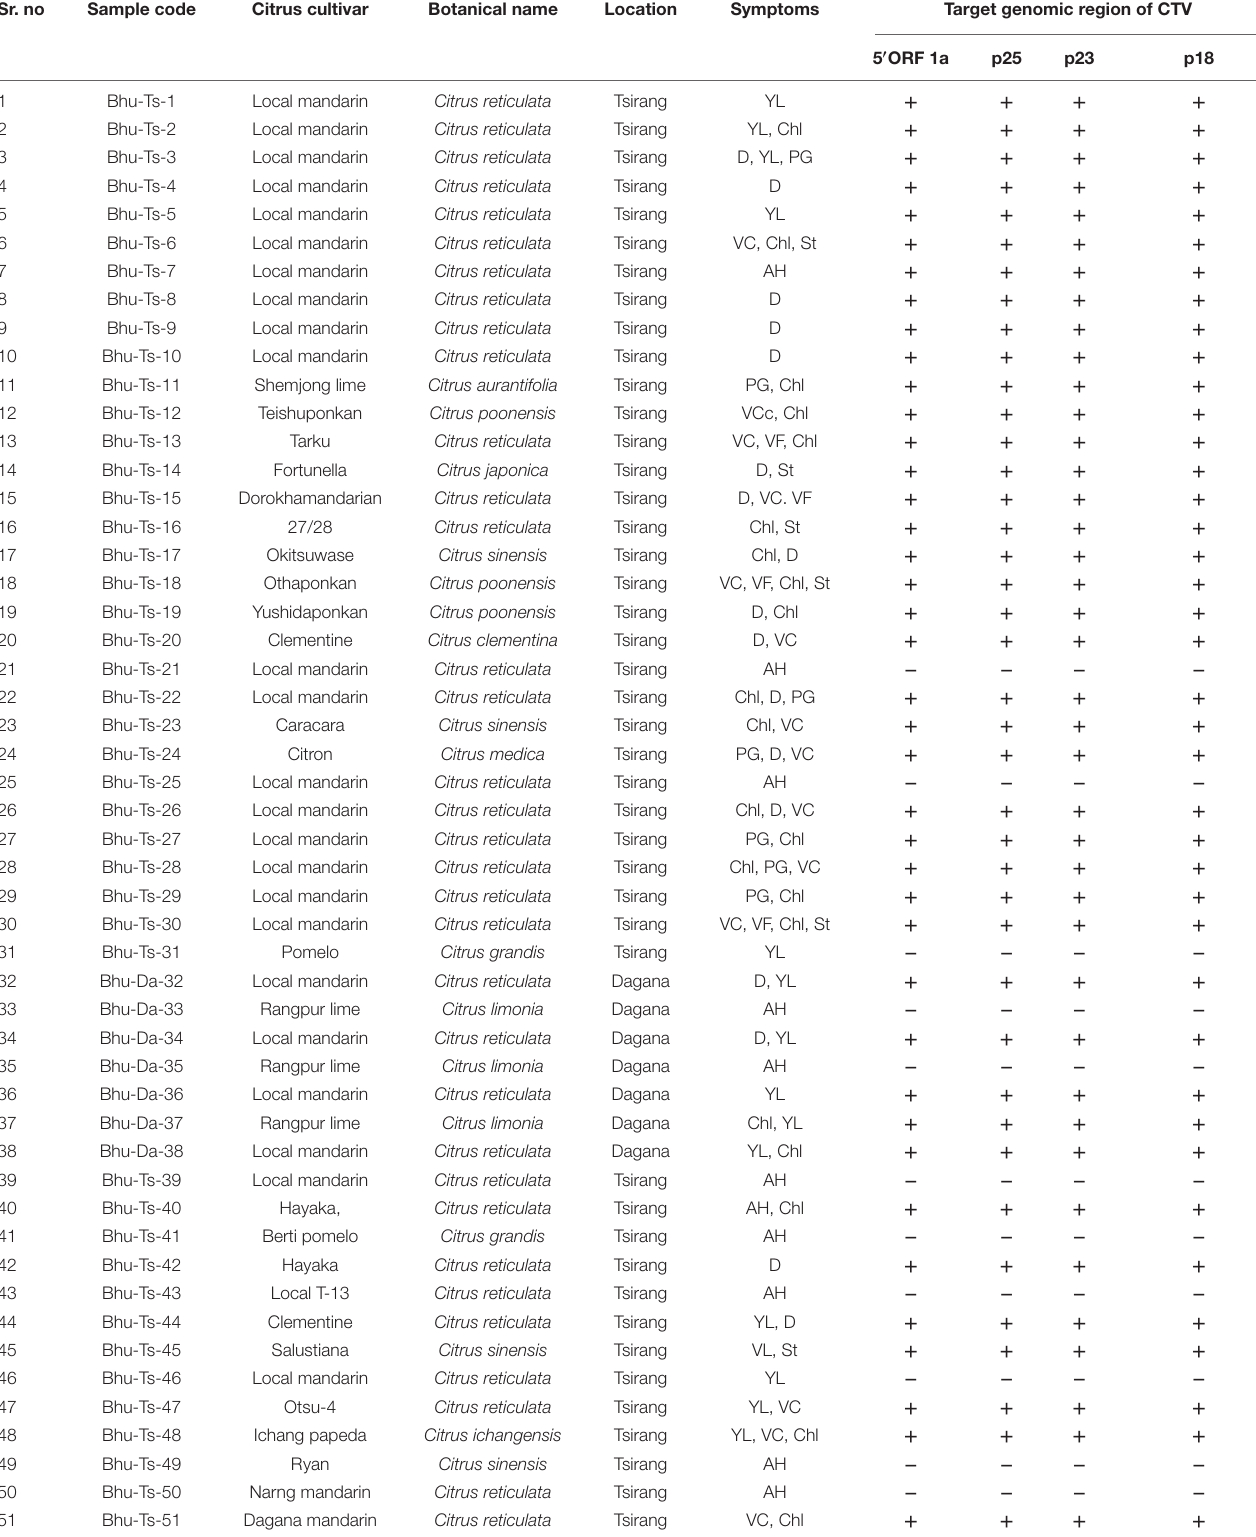
TABLE 1 | Details of samples collected from different geographical regions of Bhutan and presence or absence of citrus tristeza virus (CTV) tested by RT-PCR. Sr.